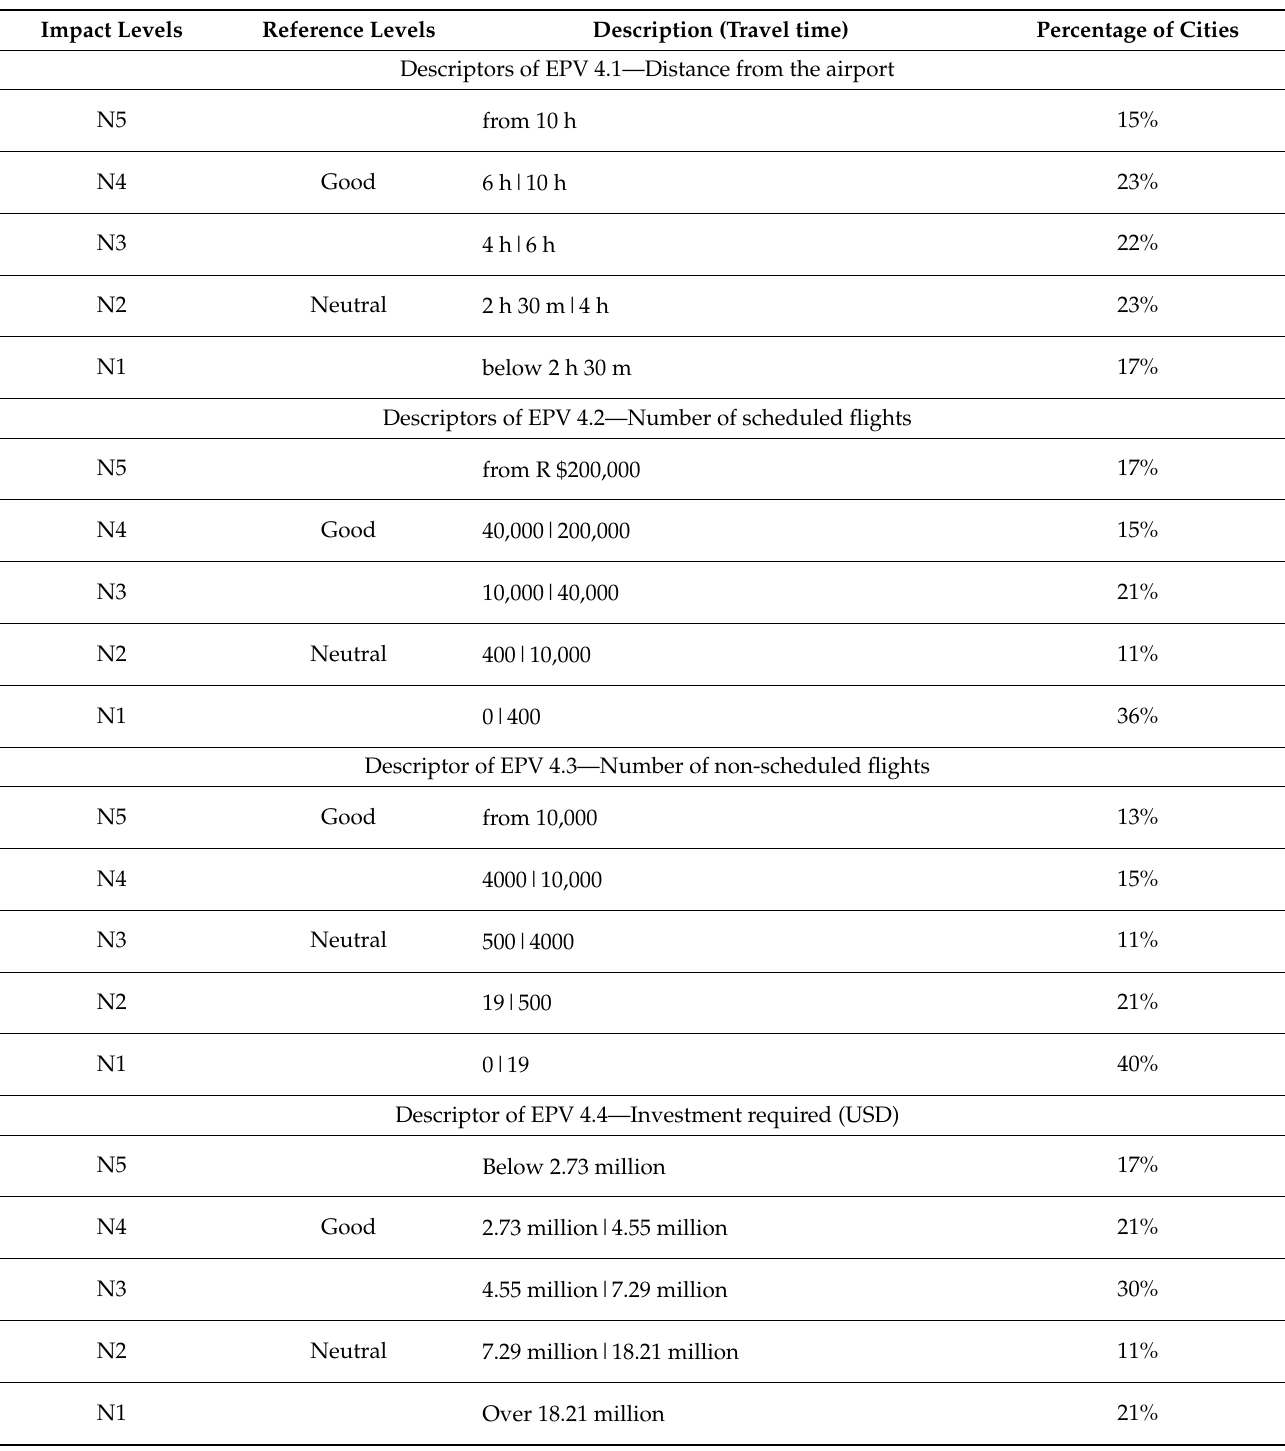
Table 5. Descriptors of FPV 4—transport